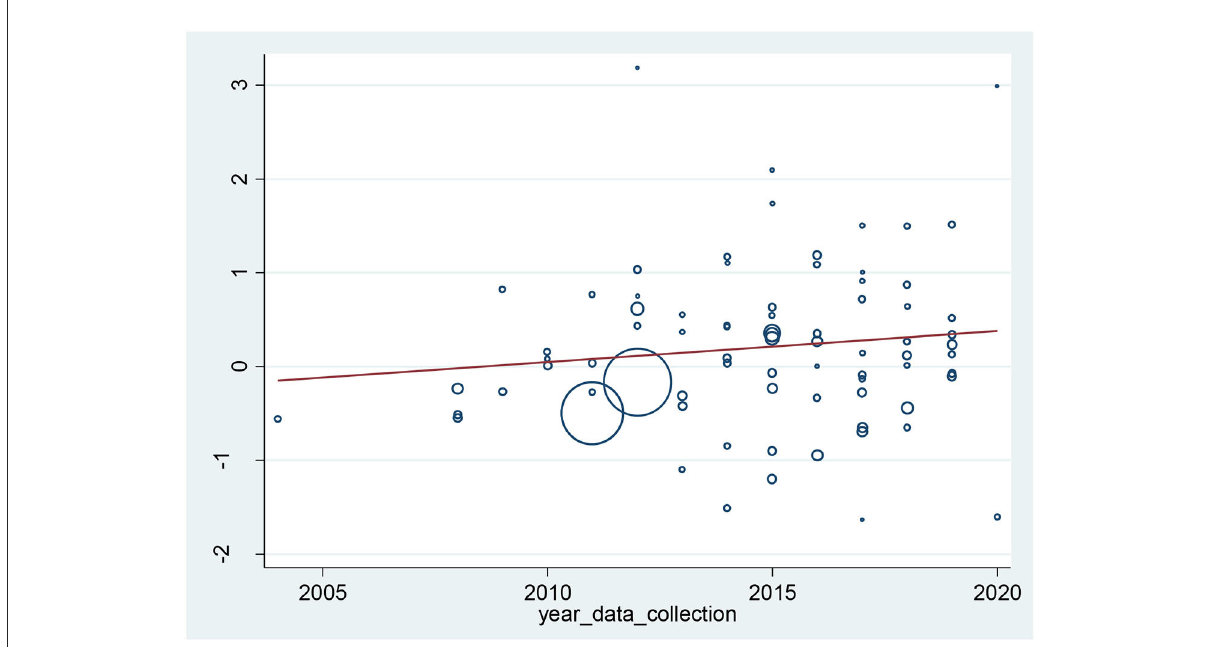
FIGURE3 Association of the prevalence of food insecurity in households with years of data collection.